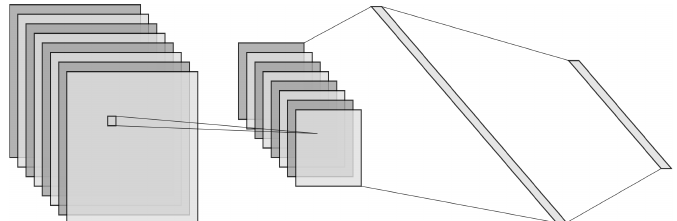
Figure 1. Simplified deep convolutional network with two (2) convolutional layers and one (1) single fully connected